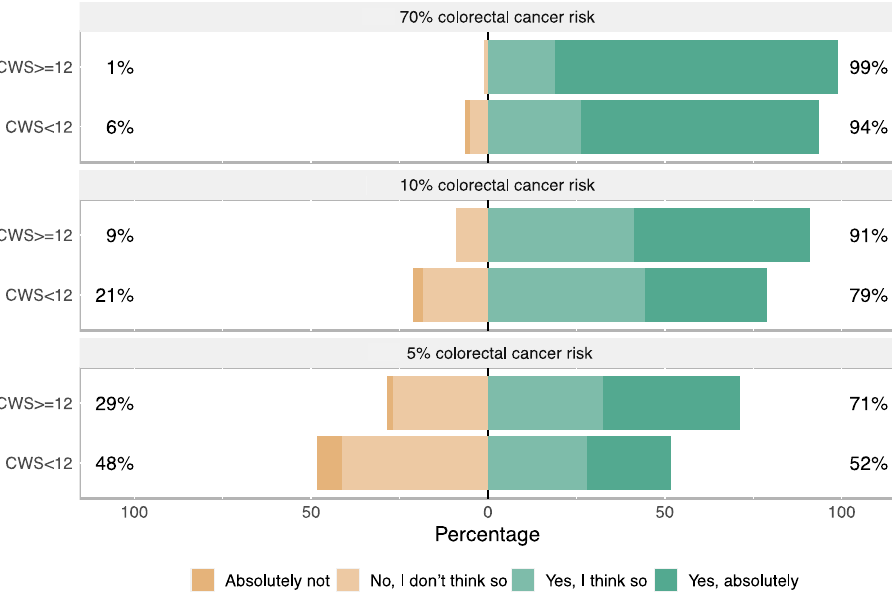
Figure 3. Intention to participate in colonoscopy screening at three levels of hypothetical colorectal cancer risk ( n = 853, without cancer history). The scenarios presented three levels risk with the corresponding colonoscopy exam intervals: 5% lifetime risk with one-time colonoscopy, 10% lifetime risk with colonoscopy every five years, and 70% with colonoscopy every second year. Differences between the proportion of respondents with high and low cancer worry were significant in all three scenarios ( p < 0.001 for bars in the two bottom panels and p = 0.025 for bars in the top panel).